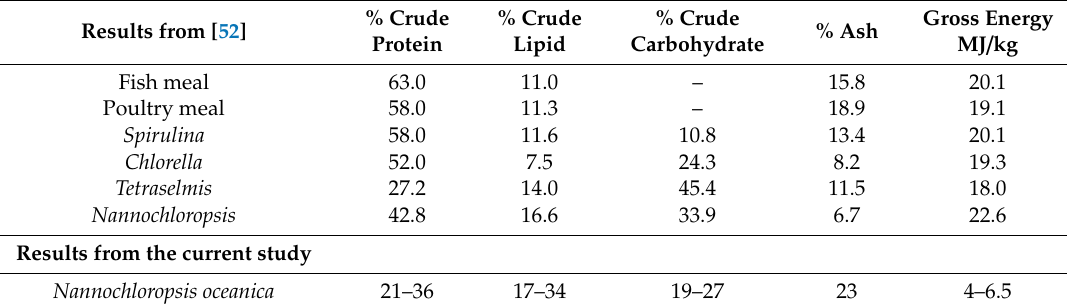
Table 6. Composition of commercially available feed ingredients and selected algal species (per dry matter) (modified from